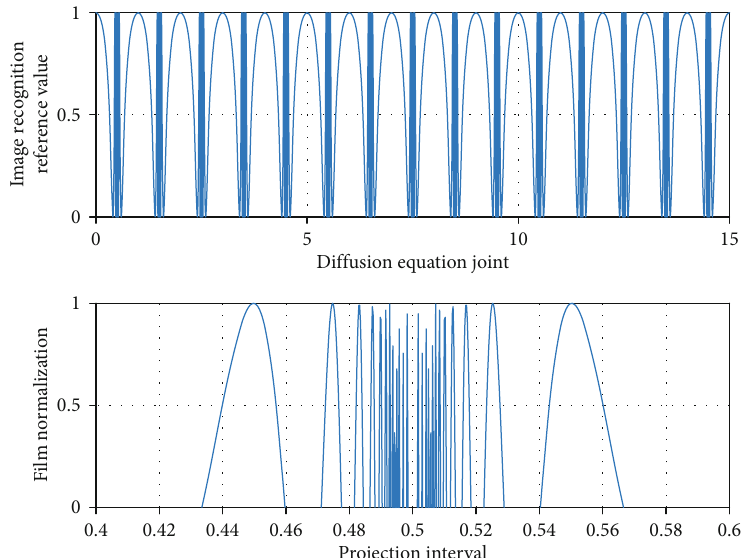
Figure 5: Accuracy of di ff usion equation image recognition for fi lm and television production.